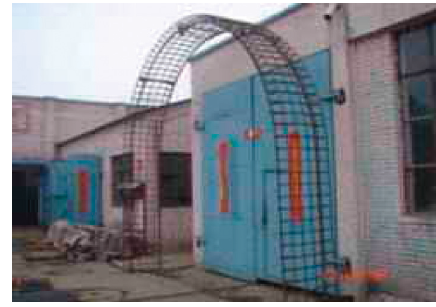
Figure 17: Assembled support.